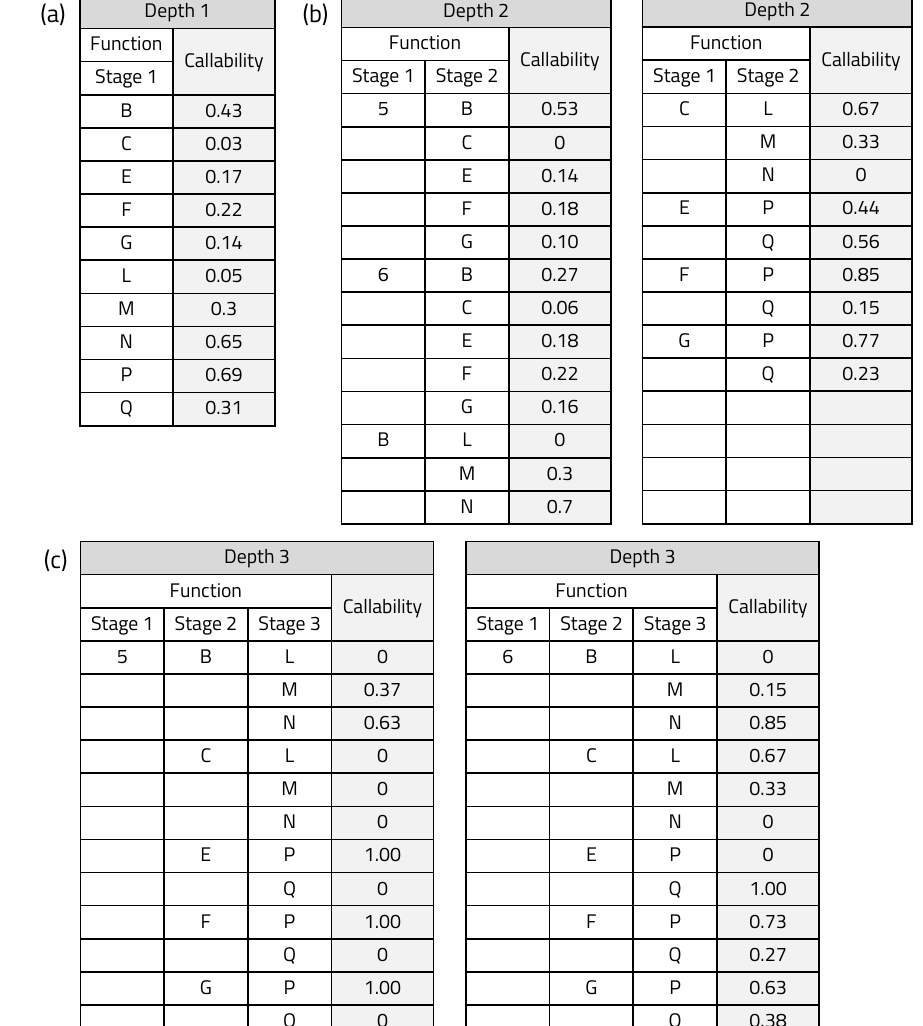
Figure 15. Callability extracted through iterative